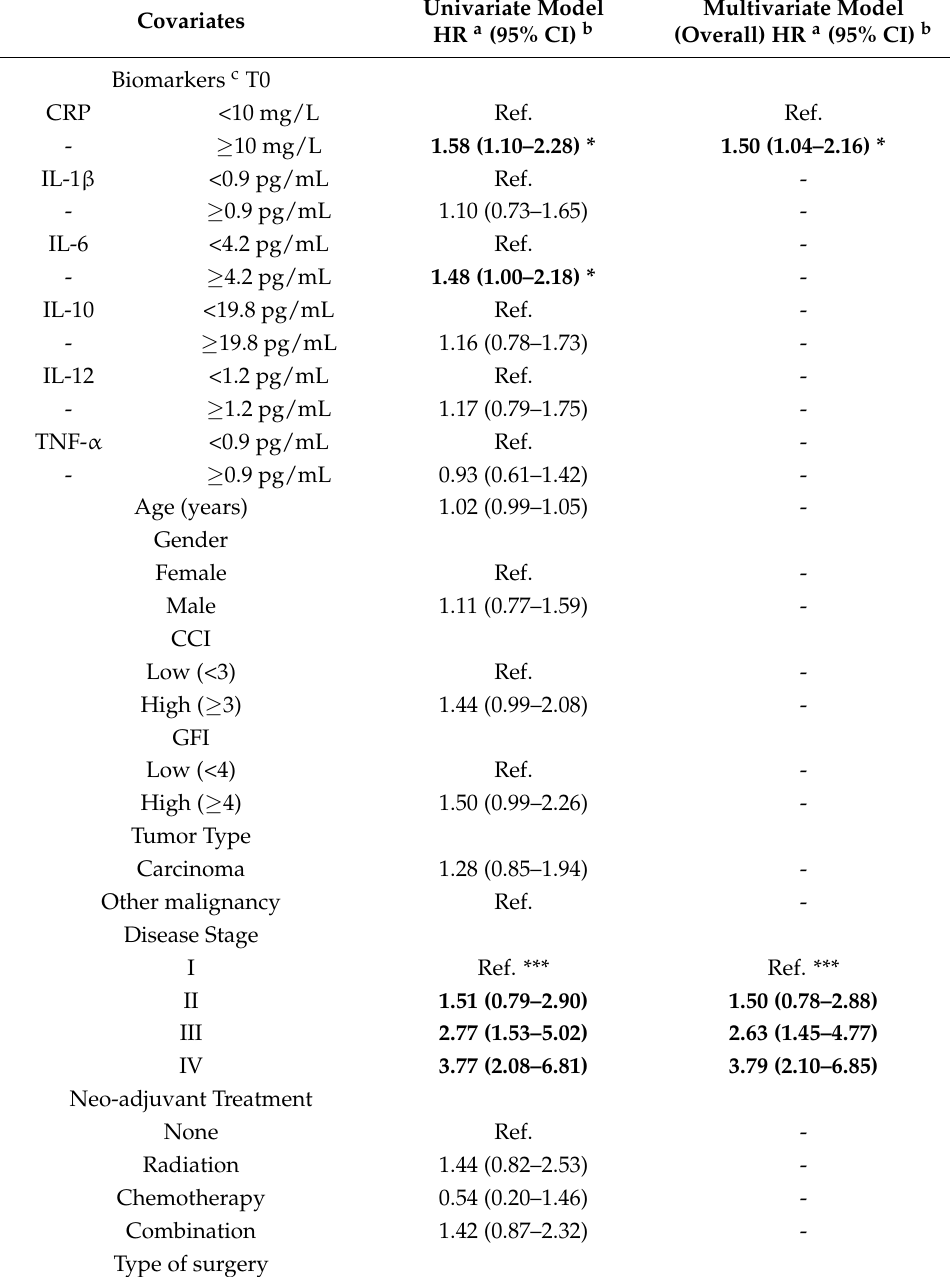
Table 2. Baseline variables related to overall survival until three years after surgery (univariate and multivariate Cox regression analysis; n =